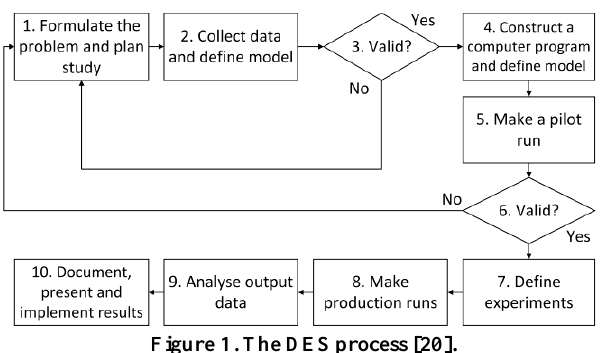
Figure 1. The DES process [20].